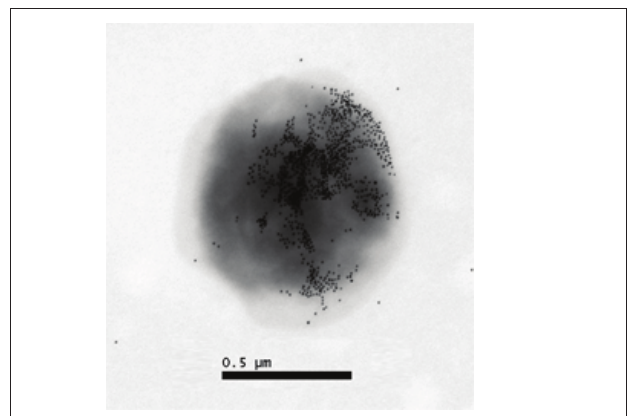
FIGure 3 | expression of FLAG-tagged PilA on the bacterial surface of a type B strain visualized by immunogold electron microscopy